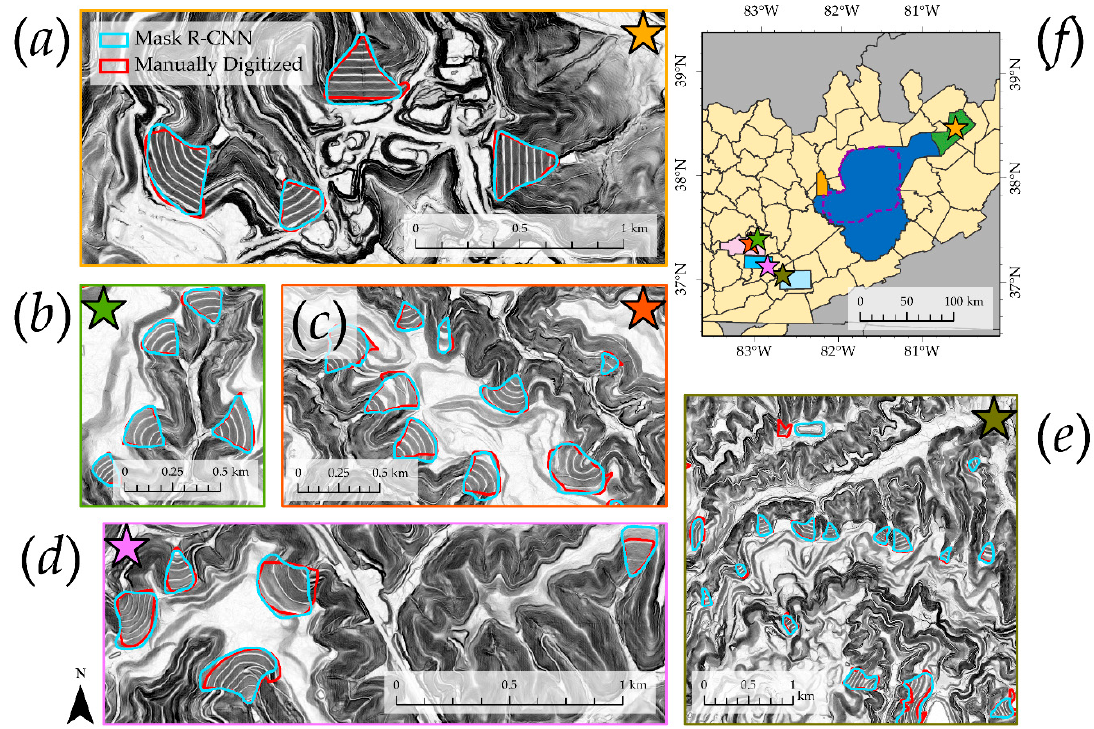
Figure 6. Example of VFF predictions and manually digitized features across multiple study areas. Stars indicate the location of ( a ) through ( e ) in the study areas ( f ).